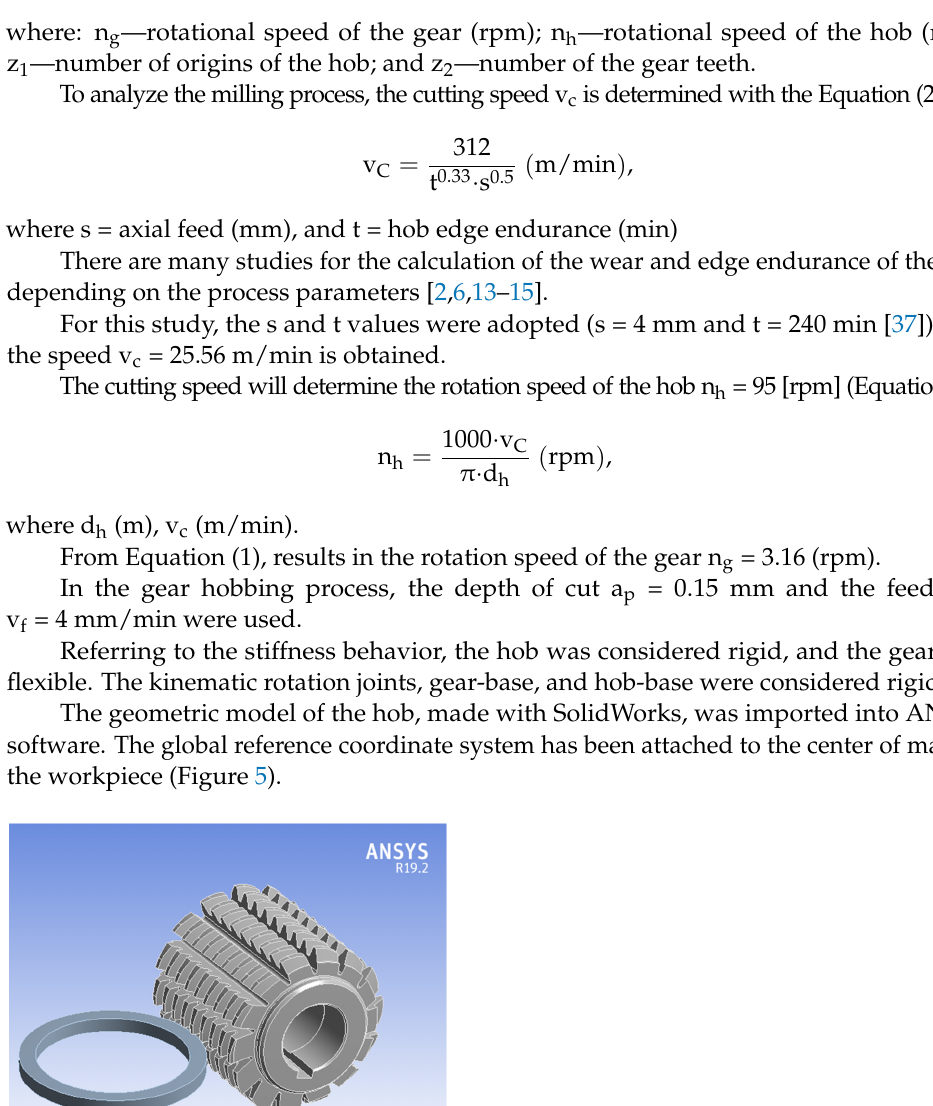
( b ) Figure 6. The meshing detail for the assembly: ( a ) overall view; ( b ) detail view of the contact surface. In order to simulate the cutting process, the parameters for the interaction between the two bodies were defined. The simulation with the ANSYS Explicit Dynamics module was performed and the obtained results in Figures 7–10 are presented.